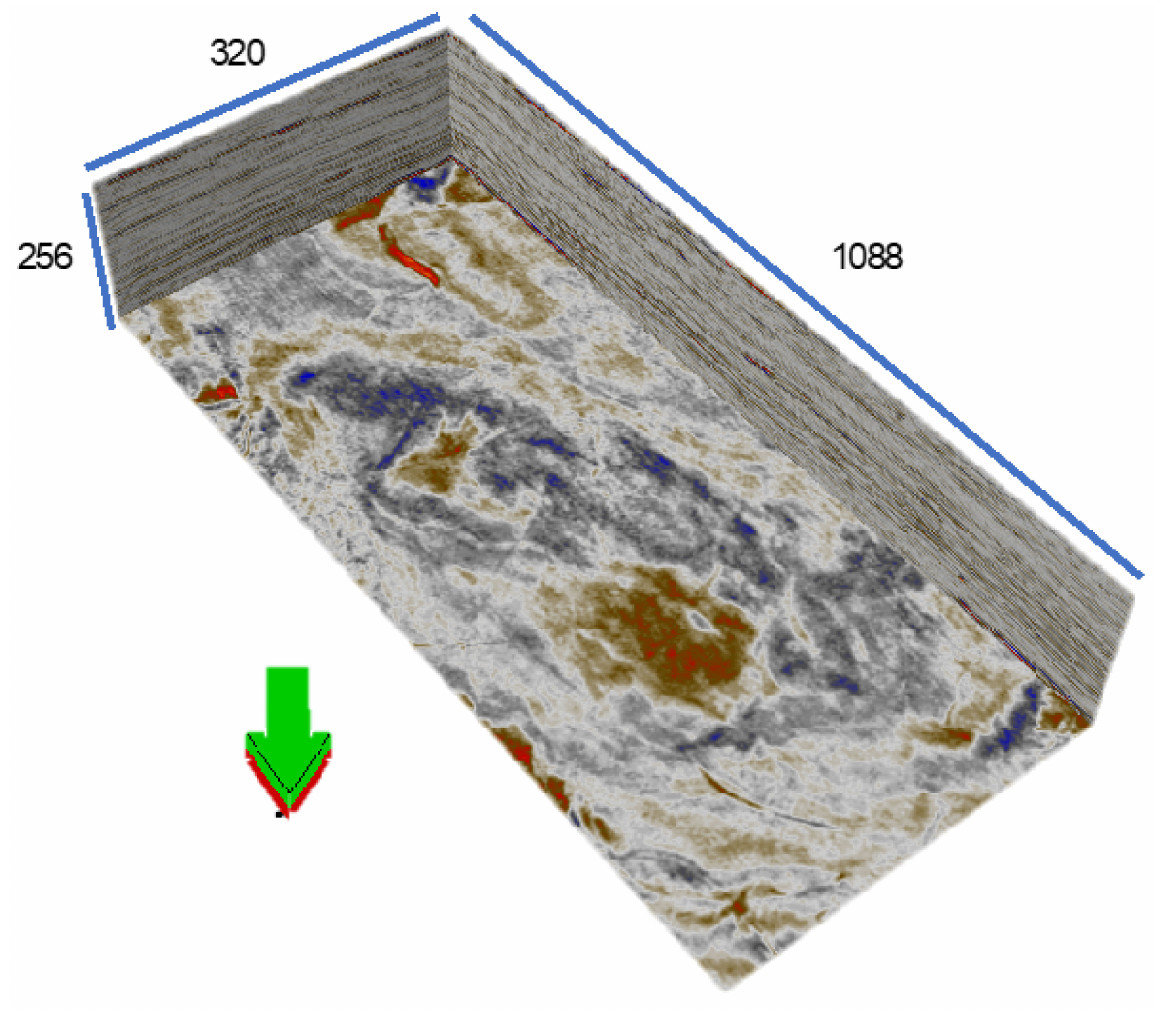
Figure 24. The 3D real seismic data, acquired from the A Field, Malay